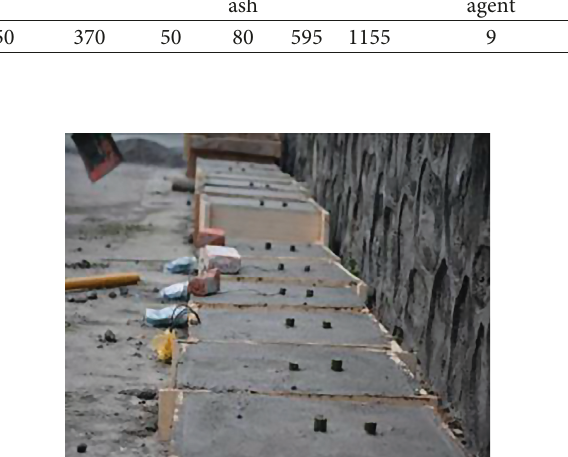
Figure 2: Concrete preparation.